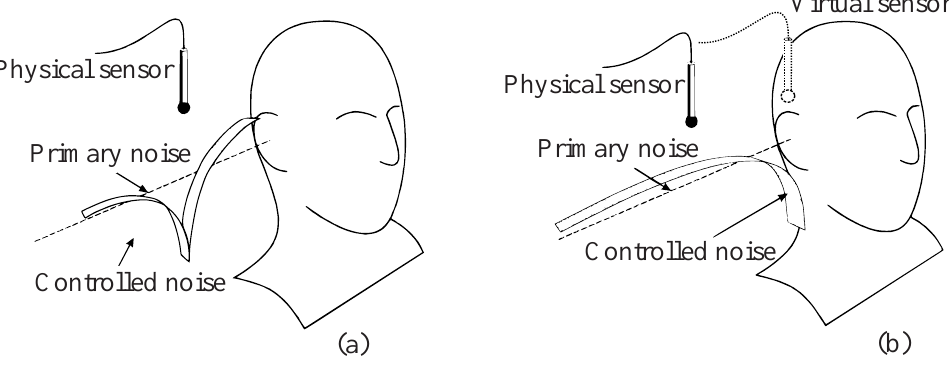
Figure 1. Comparison of local active noise control (a) at a physical sensor; and (b) at a virtual sensor.